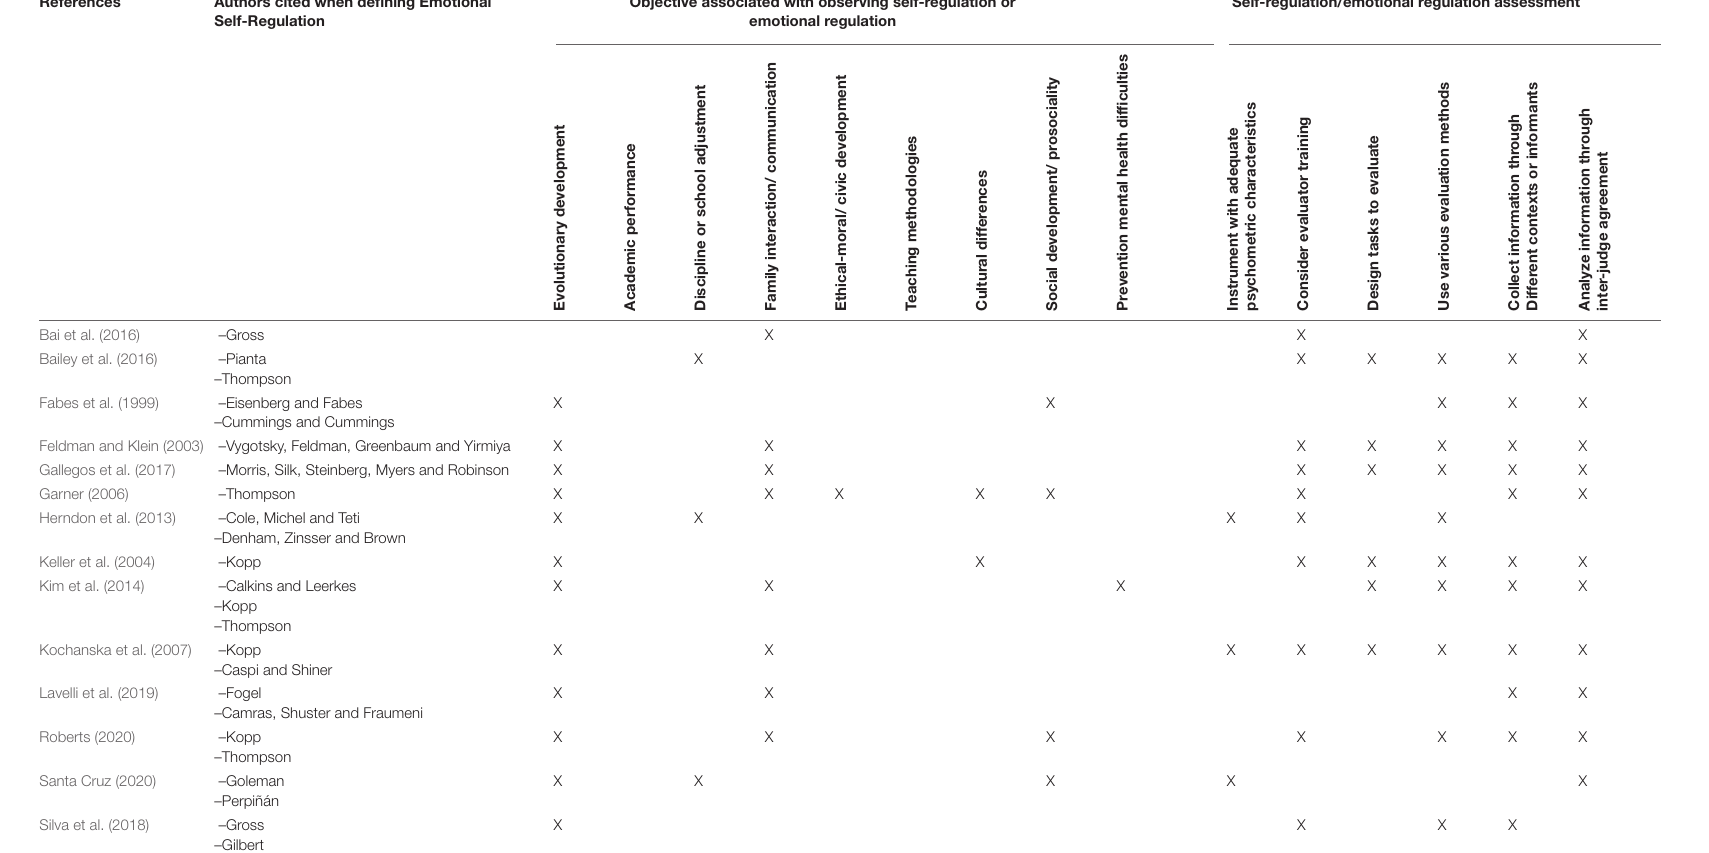
TABLE 3 | Specific objectives of